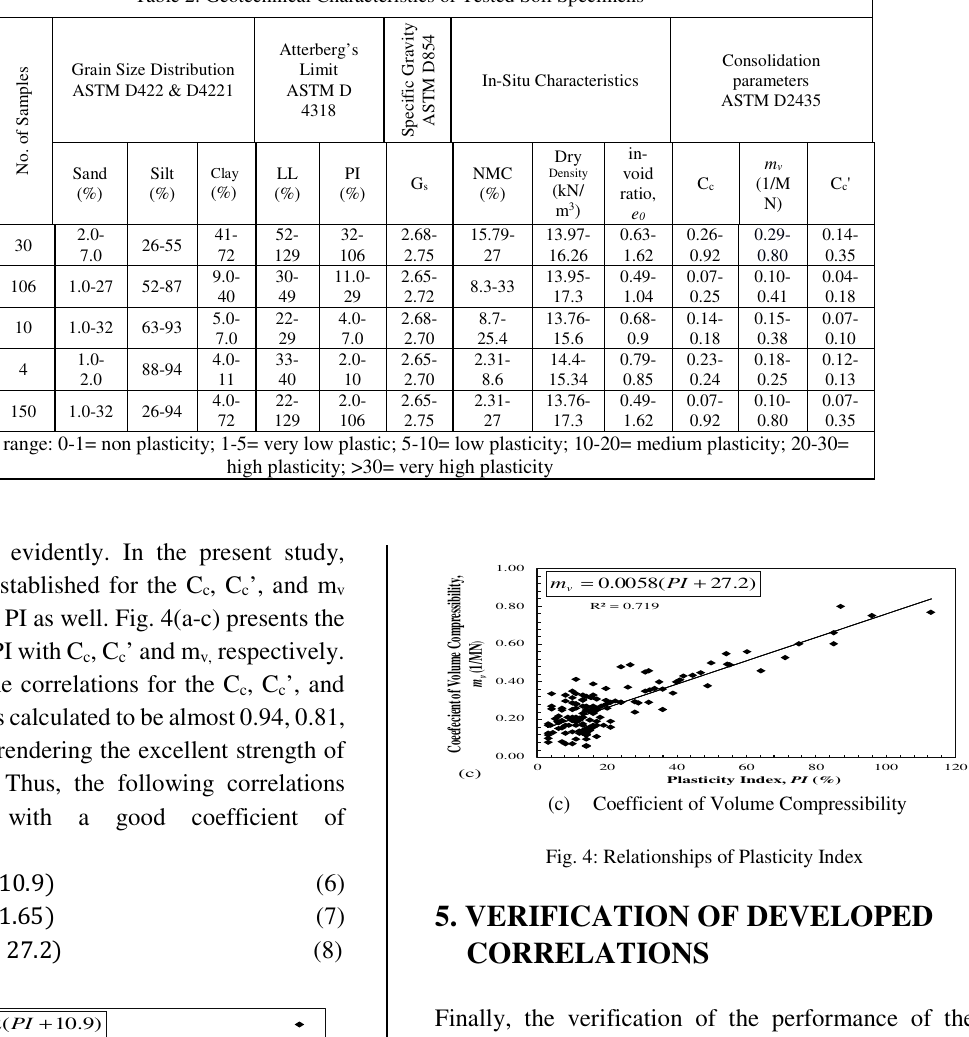
Table 2: Geotechnical Characteristics of Tested Soil Specimens